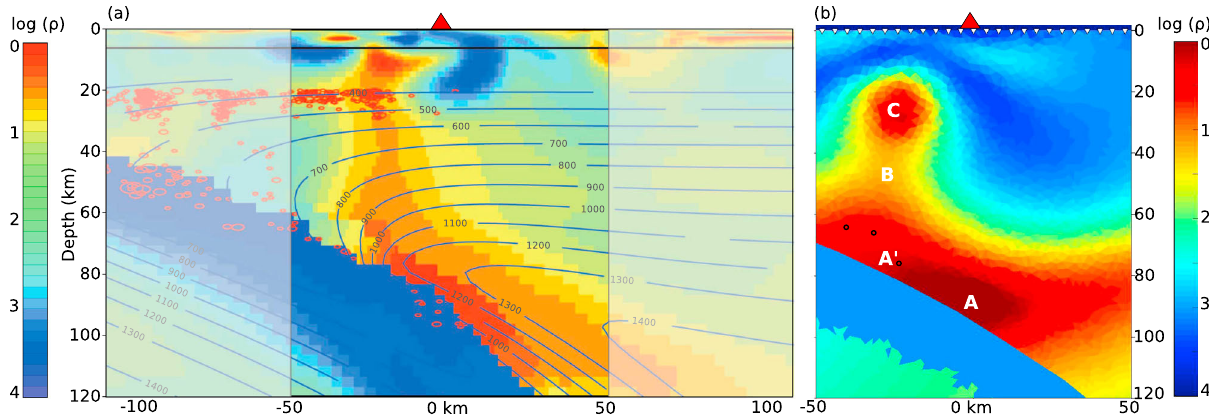
Fig. 3 Original (a) and synthetic (b) MT models for the Cascadia subduction zone. Colour scale is log electrical resistivity ( ρ ). a Shows the inverse MT model along the ‘ CAFE ’ line in the Cascadia subduction zone, western North America, adapted from McGary et al 17 with the region of interest highlighted. Reprinted by permission from Springer Nature, Nature, Pathway from subducting slab to surface for melt and fl uids beneath Mount Rainier, McGary et al 17 , ©2014. b is the synthetic MT model, which was created by forward modelling and then inverting the MT responses from a subsurface with conductivities de fi ned by mantle peridotite, arc melts, and the phlogopite-pyroxenite metasome, melt, and saline fl uids produced by melting of subducted sediments. The synthetic model reproduces the main conductive features, which are offset trenchward of Mt. Rainier (red triangle). Labels (A, A ′ , B and C) follow the regions labelled in Fig. 2. Black circles in ( b ) show the locations of small (magnitude < 3) earthquakes that have occurred in the mantle wedge since regions are modelled just above the slab surface (regions A and A ′ ), induced by high temperatures and sediment melt, and from ~10 – 30 km depth 20 – 30 km trenchward of the volcano (region